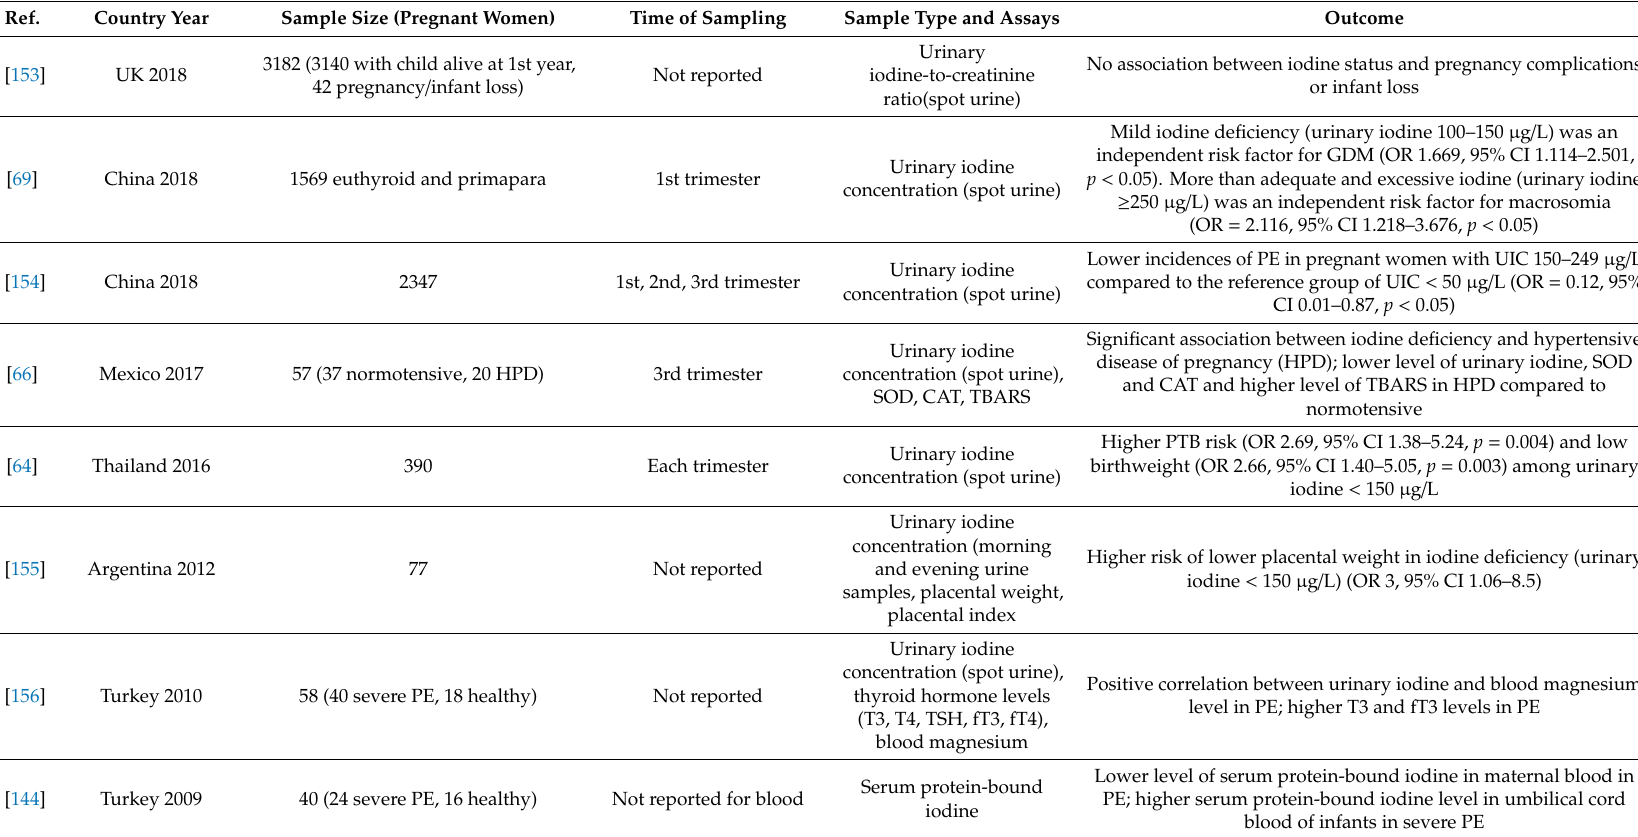
Table 3. Iodine status and pregnancy